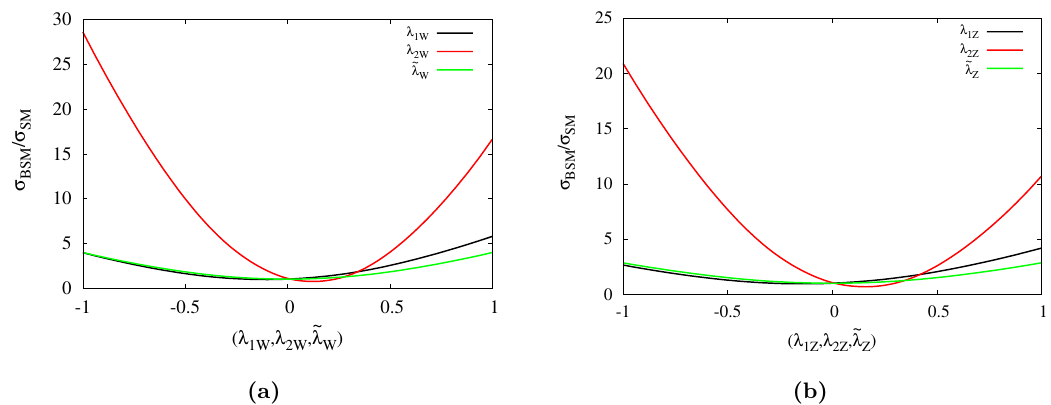
Figure 3 . Variation of CC (left) and NC (right) cross sections with respect to the non-trivial BSM